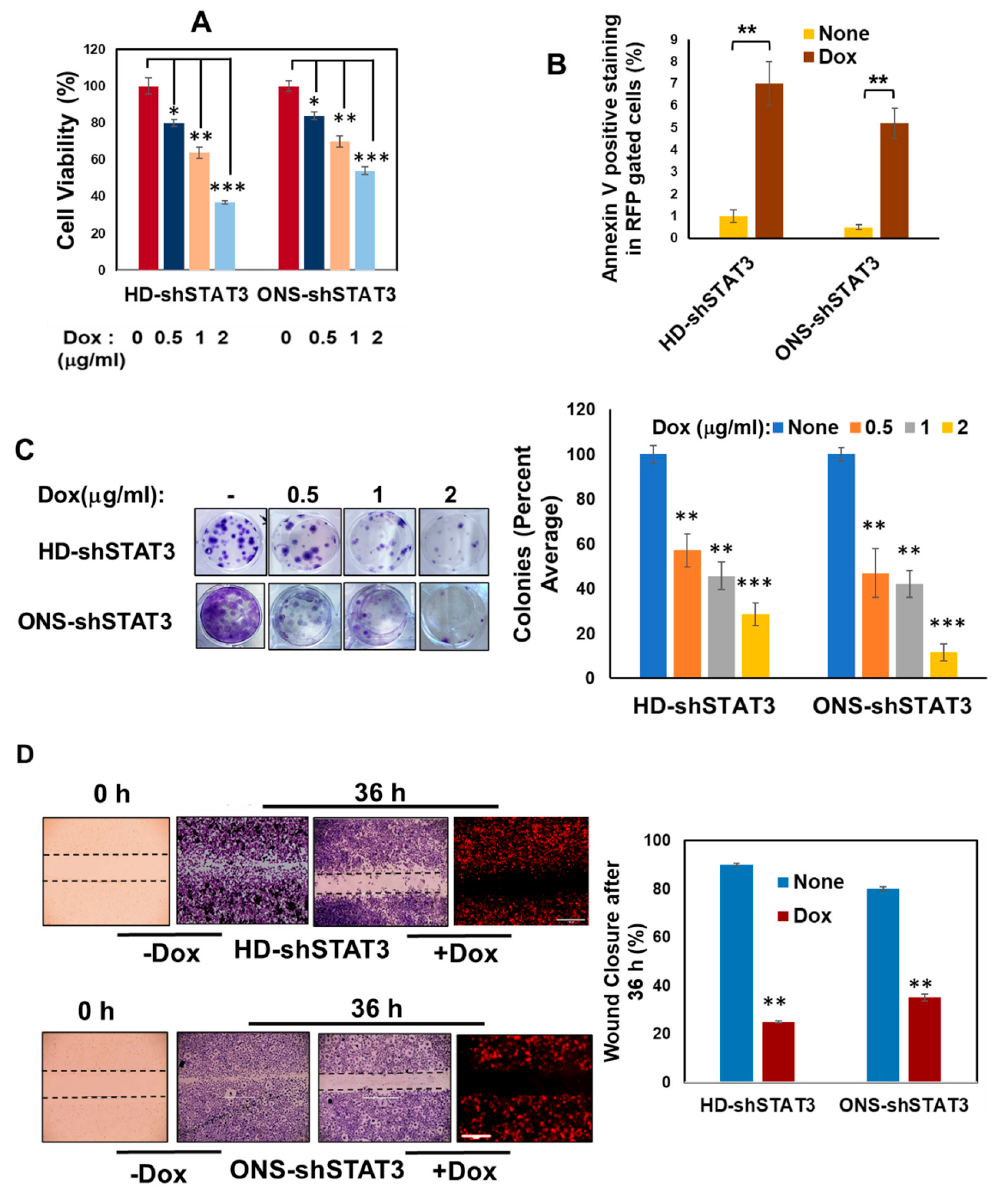
Figure 2. Effect of STAT3 KD on cell viability, apoptosis, cell growth and migration. ( A ) HD-shSTAT3 and ONS-shSTAT3 MB cells were treated either with Dox at a concentration of 0.5, 1, or 2 µg/mL or left untreated. The growth of these cells was determined at 48 h using MTT assays. The values represent the means ± SD from five wells of a 96-well plate; * p < 0.05, ** p < 0.01 and *** p < 0.001. ( B ) MB cell lines were treated either with Dox at a concentration of 0.5 µg/mL for 48 h or left untreated. RFP expressing cells were gated and the percentage of cells undergoing apoptosis was determined using an annexin-V-FITC apoptosis detection kit. Representative figure shows a bar graph of quantification of the apoptotic cells from one of three independent experiments; ** p < 0.01. ( C ) Equal numbers of cells (~400) were seeded in 6-well plates and were treated with either 0.5, 1, or 2 µg/mL of Dox or left untreated for 10–14 days. Colonies formed were fi xed with acetic acid/methanol 1:7 ( v / v ) and stained with 0.5% crystal violet solution. Number of colonies were counted from triplicate wells and are shown in bar diagram (right); ** p < 0.01 and *** p < 0.001. ( D ) Wound-healing assays were performed on cells seeded into 6-well assay plates until a monolayer formed. A cell-free gap/scratch was created in which the cell migration was analyzed in the presence of 0.5 µg/mL Dox. Representative images of cell migration are shown after 36 h; ** p < 0.01.